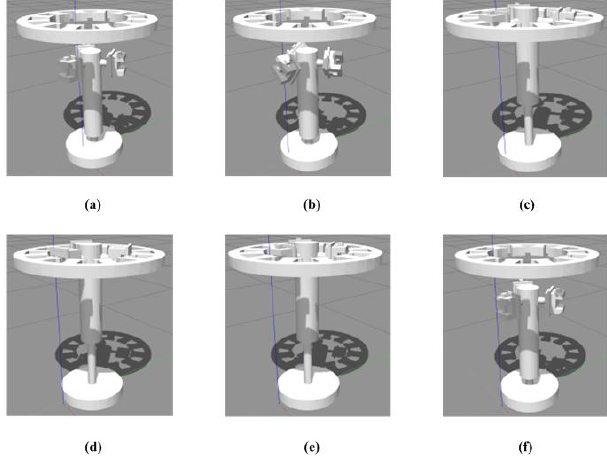
Figure 16. MoveIt